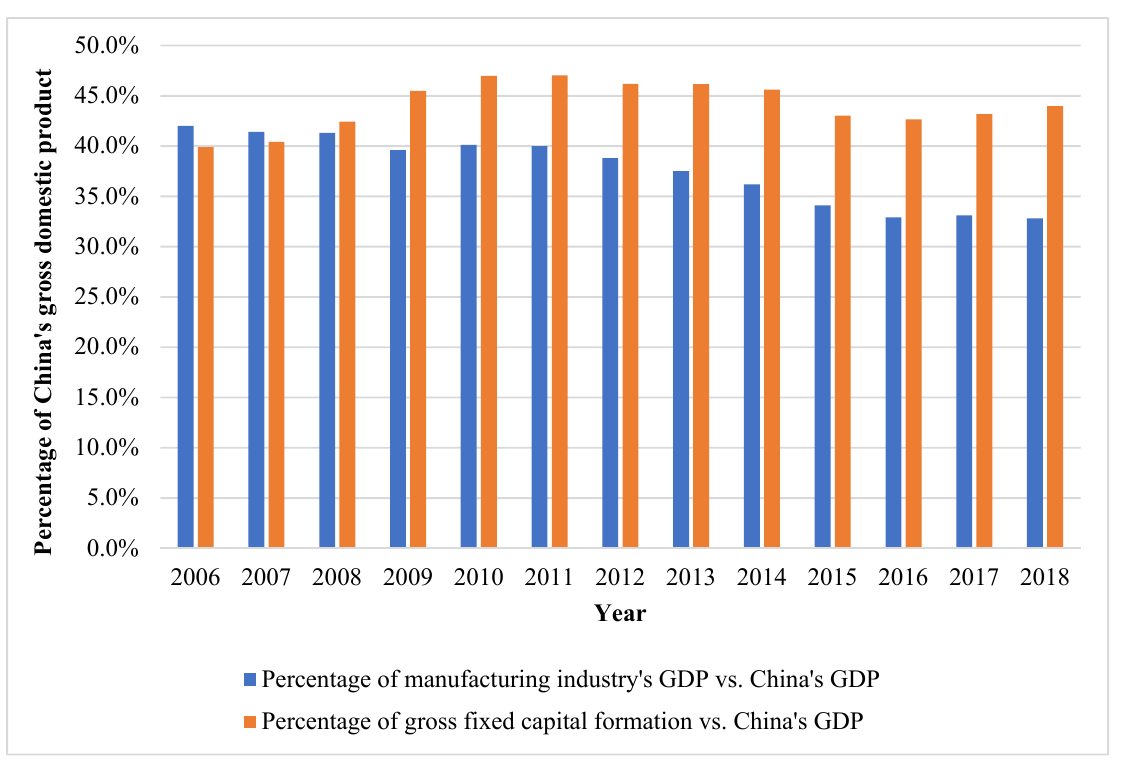
Figure 1. The percentages of the manufacturing industry’s GDP and gross fixed capital formation over China’s GDP.